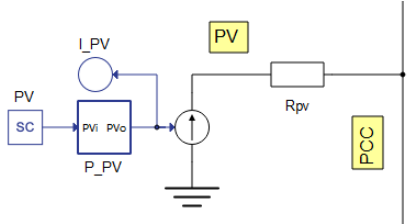
Figure 17. PV generator experiment blocks.